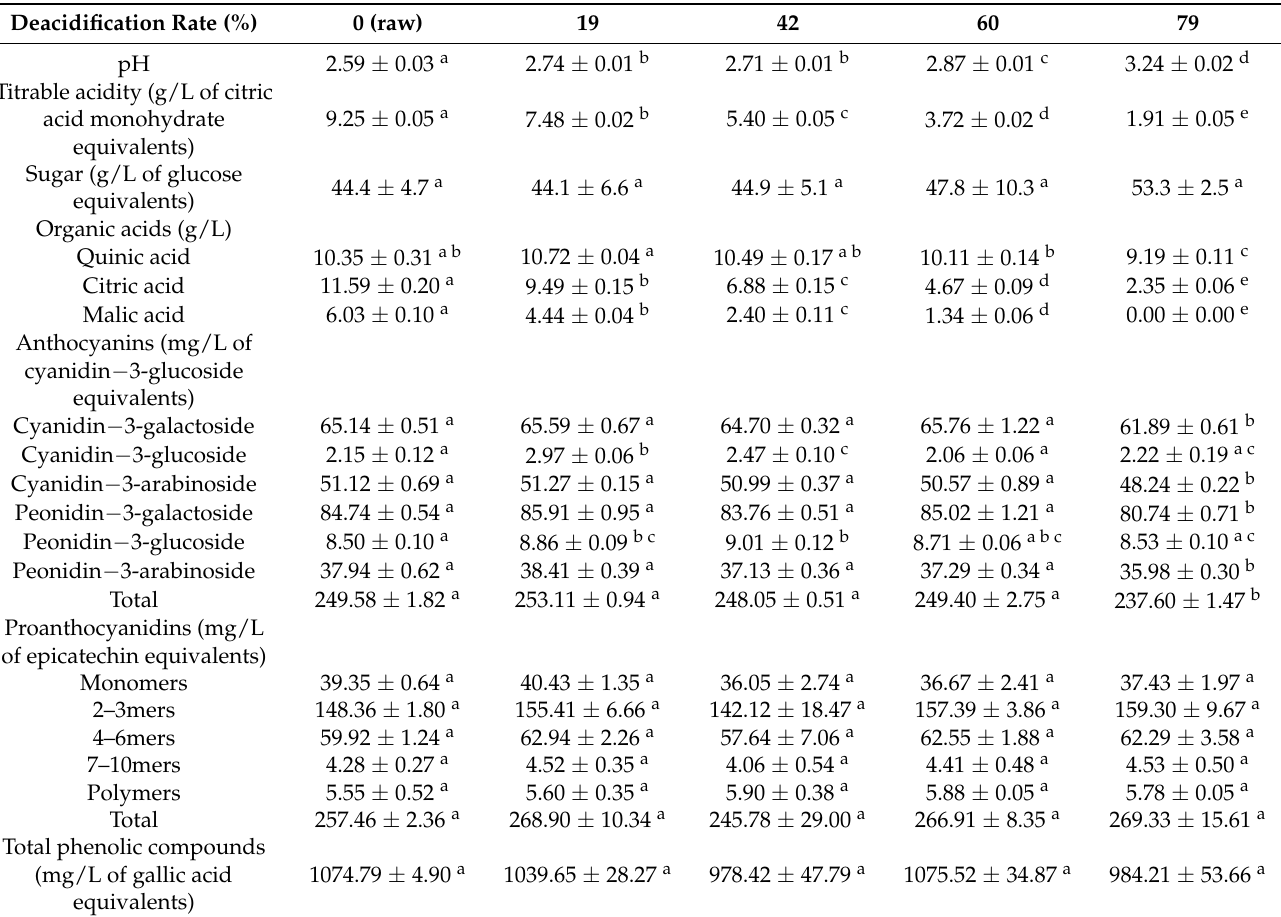
Table 1. Physicochemical composition of the raw and deacidified cranberry